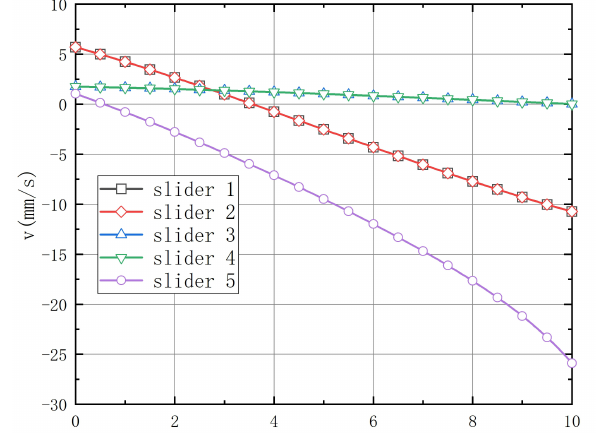
Figure 10. Velocity curves of sliders.